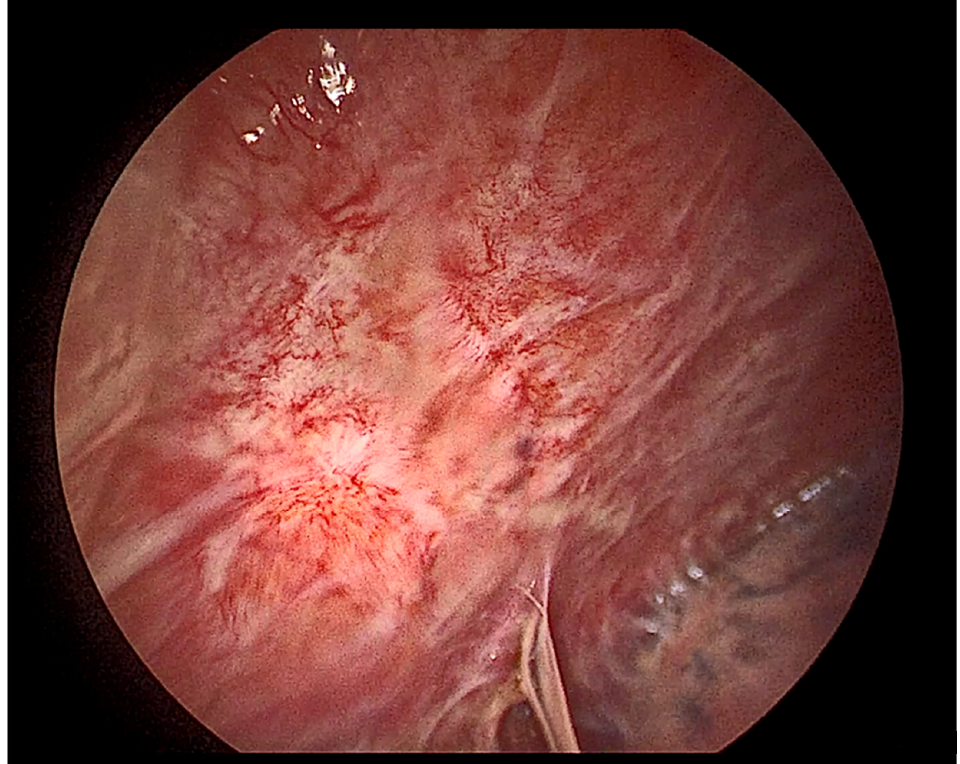
Figure 11. Thoracoscopic view of a mildly inflamed pleura.